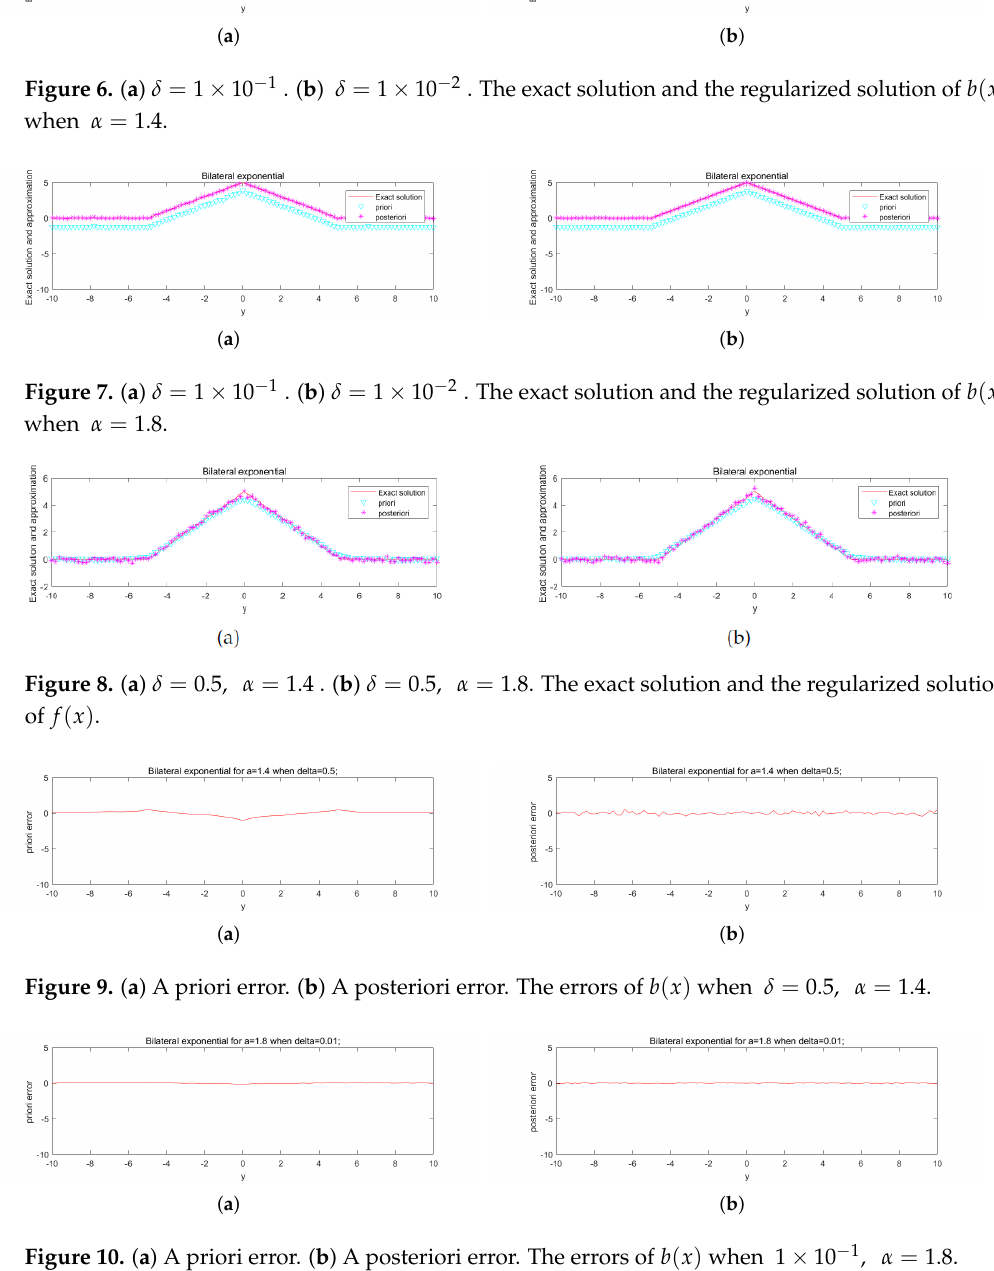
Figure 10. ( a ) A priori error. ( b ) A posteriori error. The errors of b ( x ) when 1 × 10 − 1 , α = 1.8.